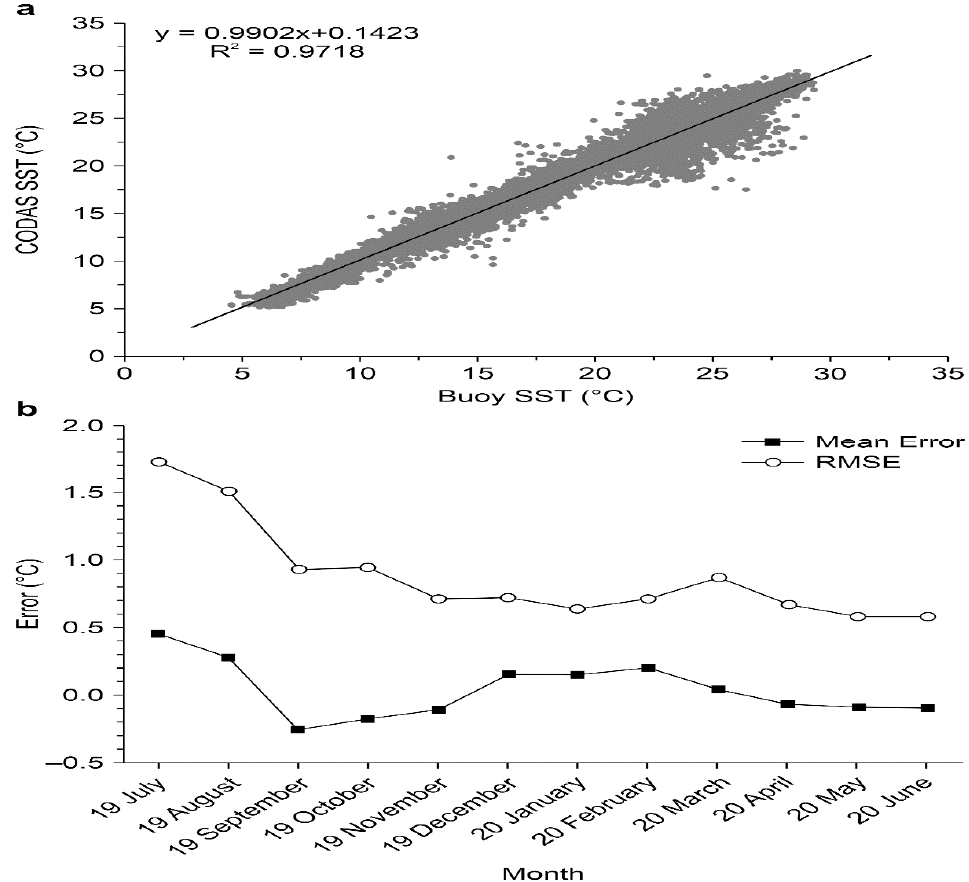
Figure 3. Verification of 6h fusion SSTs. ( a ) 6h SST scatter plots of CODAS and buoy sites; ( b ) time series of the mean error and RMSE from July 2019 to June 2020. series of the mean error and RMSE from July 2019 to June